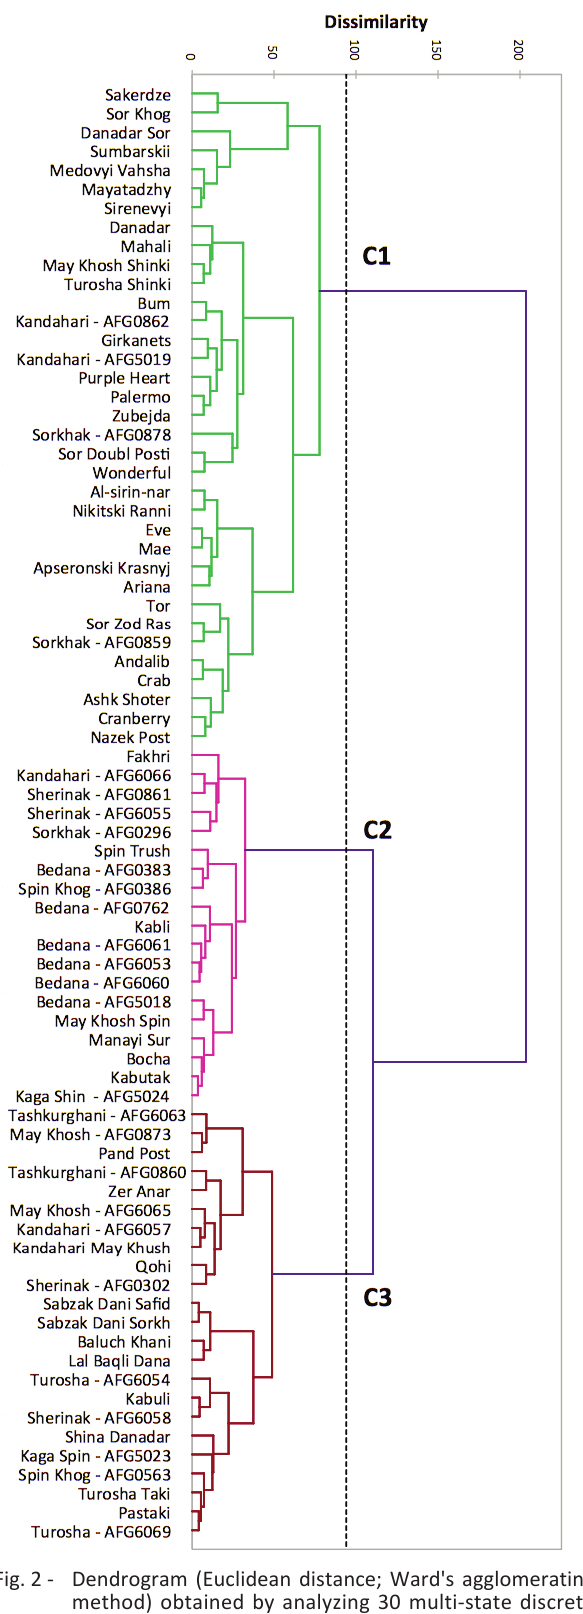
Fig. 2 - Dendrogram (Euclidean distance; Ward's agglomerating method) obtained by analyzing 30 multi-state discrete morphological variables of 58 pomegranate accessions of Afghan origin and 19 imported varieties belonging to the National Collection of Fruits and Nuts of Afghanistan (bold: imported cultivars; bold cursive: putative ‘Bedana’ type; cursive: putative ‘Kandahari’